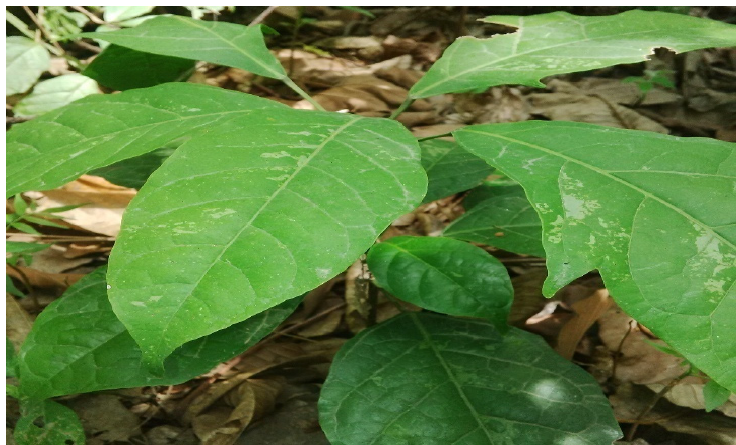
Figure 1. Sphenocentrum jollyanum in its natural habitat .